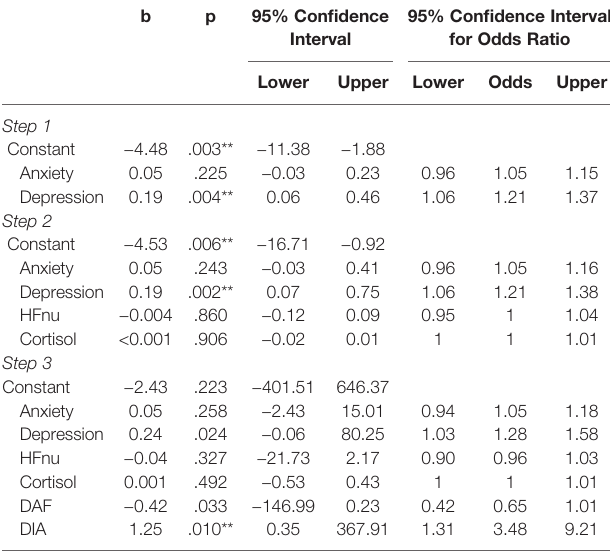
TABLE 2 | Summary of hierarchical logistical regression analysis predicting the presence of irritable bowel syndrome (IBS) (95% BCa bootstrap con fi dence intervals based on 5,000 samples).